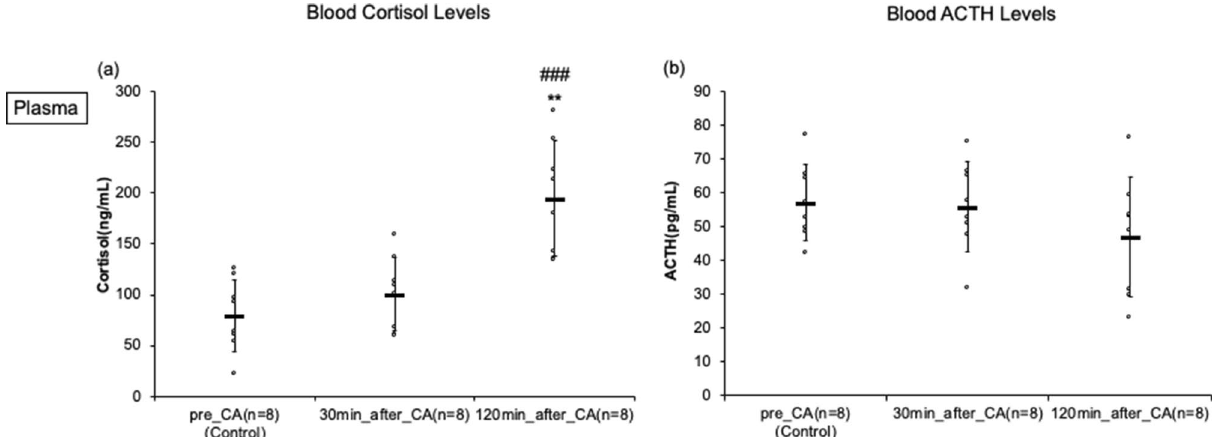
Figure 6. Cortisol and ACTH plasma levels by enzyme-linked immunosorbent assay in asphyxial cardiac arrest (CA) rats. ( a ) blood cortisol level. ( b ) blood ACTH level. ### p < 0.001 compared with the pre-CA group. ** p < 0.01 compared with 30 min post-CA